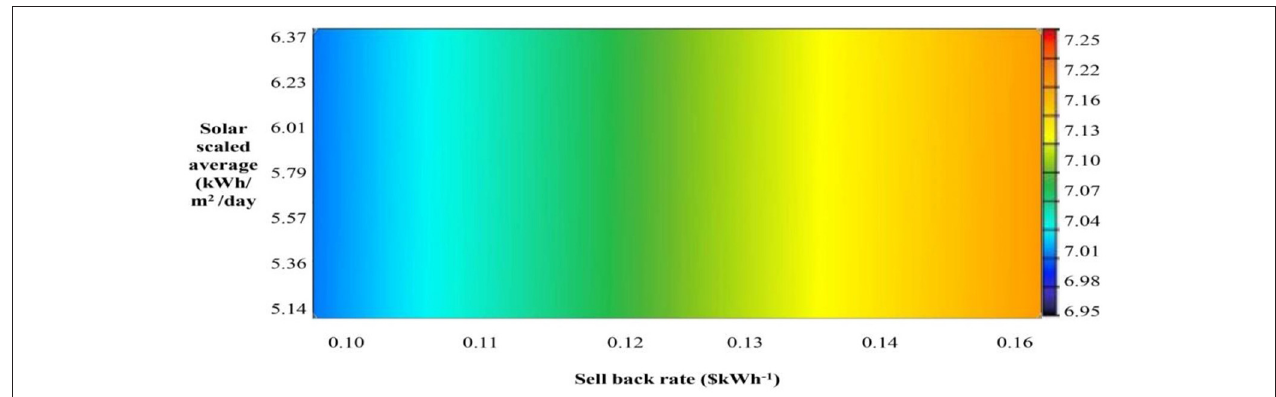
FIGURE 14 | Cost of electricity (COE).